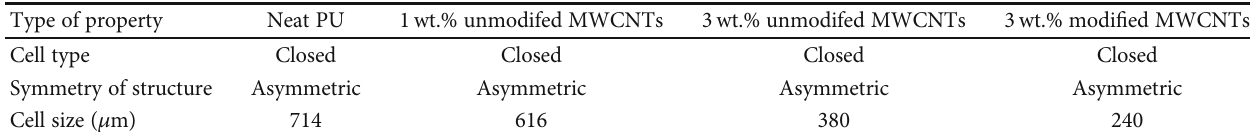
Figure 5: SEM micrographs of (a) original PU foam and foam nanocomposites containing (b) 1 wt.% MWCNTs, (c) 3 wt.% MWCNTs, and Table 4: Microstructural results of foam nanocomposites.